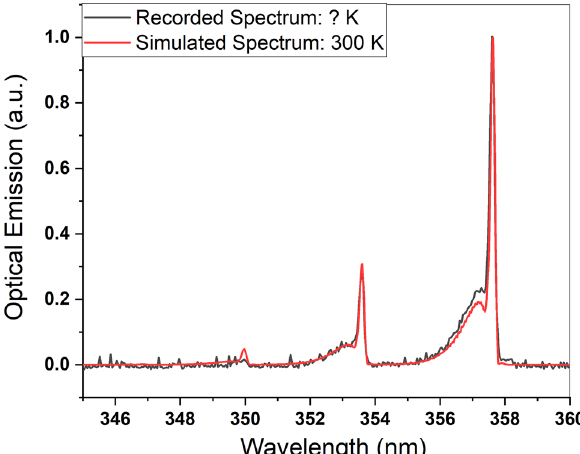
Figure 2. Specair simulated vs. experimental recorded